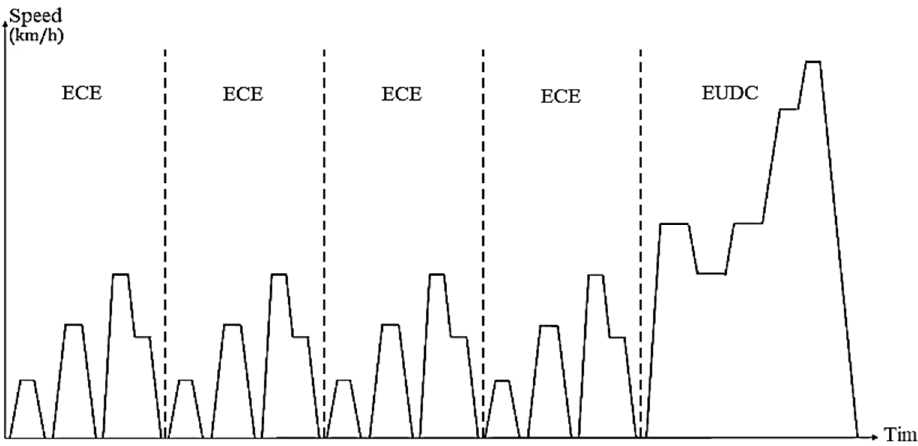
Figure 1. The driving cycles of ECE and EUDC.